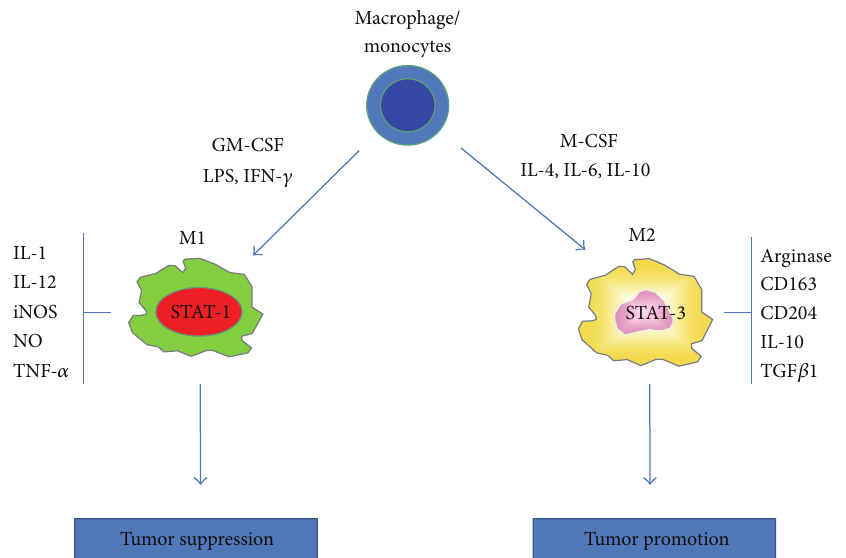
Figure 2: CNS macrophage/monocytes differentiate into polarized macrophage subsets when exposed to different cytokine milieu. In the presence of granulocyte-macrophage colony stimulating factor (GM-CSF), interferon-(IFN) 𝛾 , lipopolysaccharide (LPS) and other microbial products,monocytesdifferentiateintoM1macrophages.Inthepresenceofmacrophagecolonystimulatingfactor(M-CSF),interleukin-(IL)4, IL-6, IL-10 and immune suppressive molecules (corticosteroids, vitamin D3, prostaglandins), monocytes differentiate into M2 macrophages. M1 and M2 subsets differ in terms of phenotype and functions. M1 cells have high anti-microbial activity, immune stimulatory functions and tumor cytotoxicity and express the signal transducer and activator of transcription 1 (STAT-1). M2 cells have high scavenging ability, promote tissue repair and angiogenesis, favor tumor progression and express STAT-3.